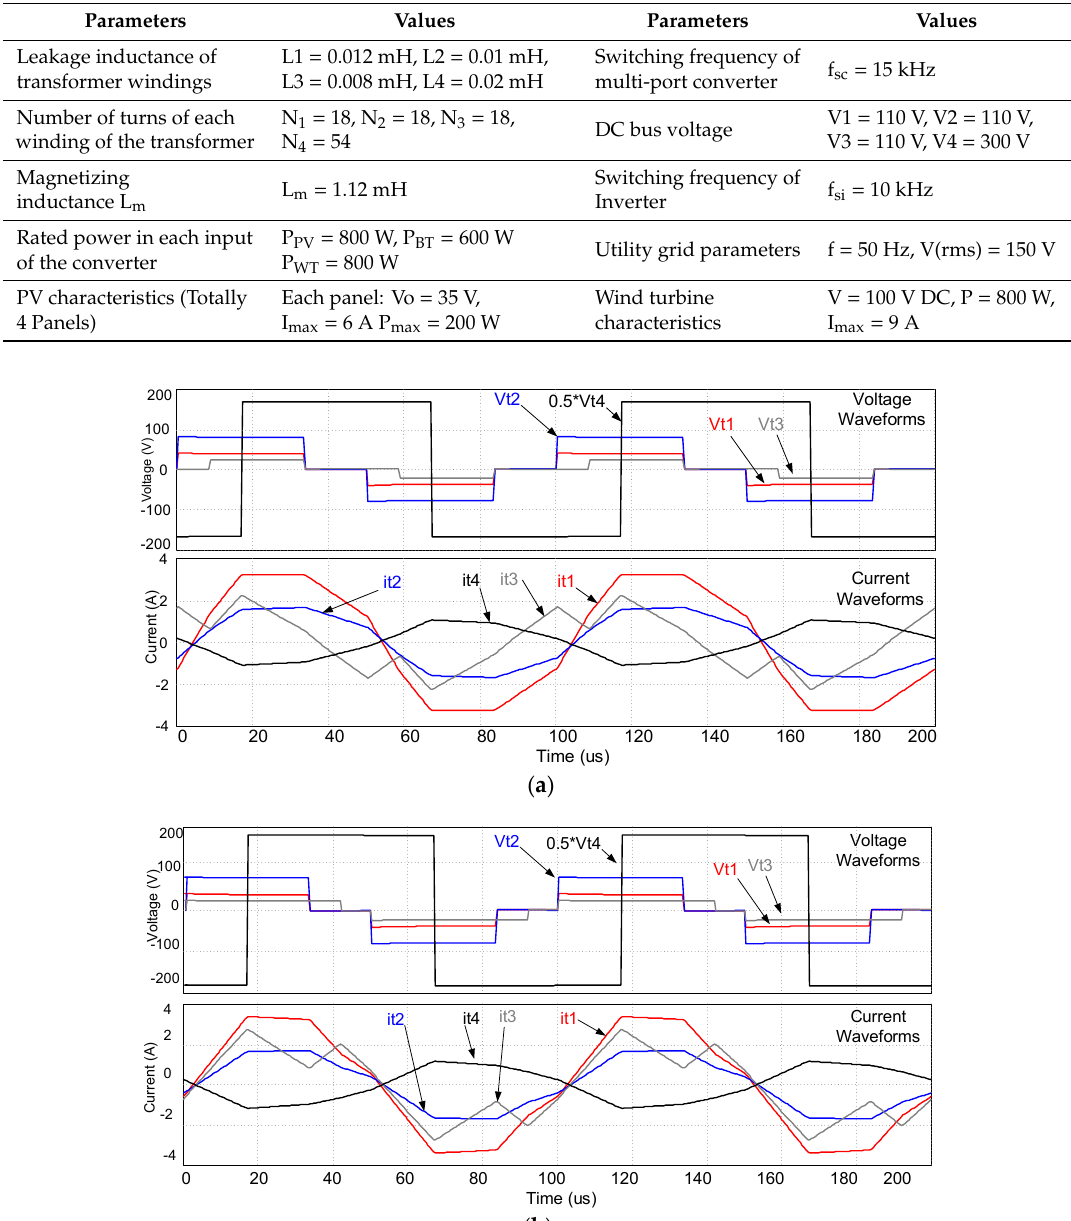
Table 1. System parameters for numerical simulations.